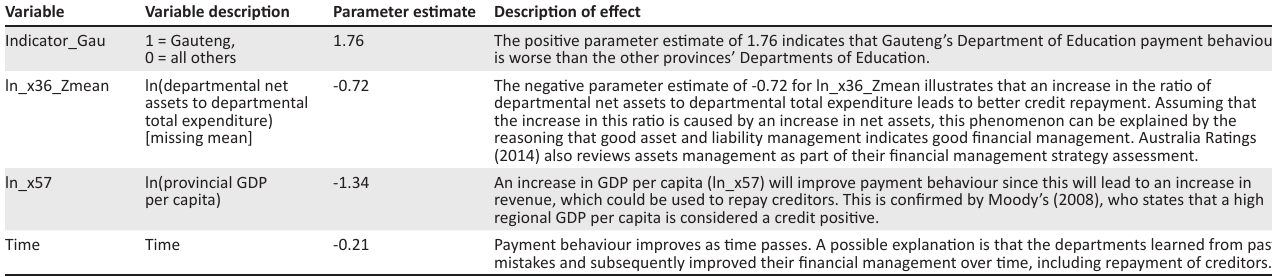
TABLE 4: Details of the Education Basic Model , specifically developed for the Department of Education. Variable Variable description